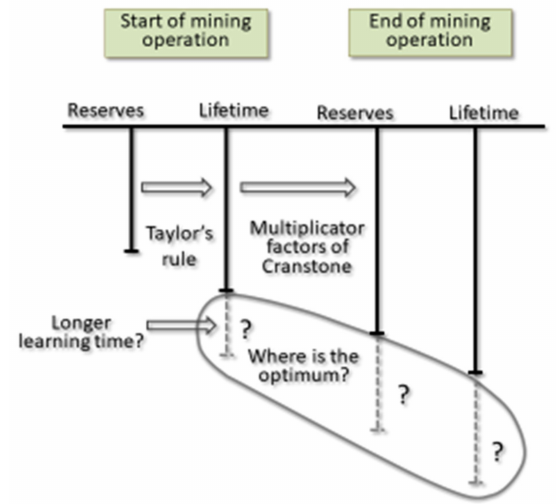
Figure 13. Schematic diagram: What is the optimal lifetime of a mine, taking into account learning effects? The vertical bars represent the sizes of reserves and lifetimes at the start and end of a mining operation